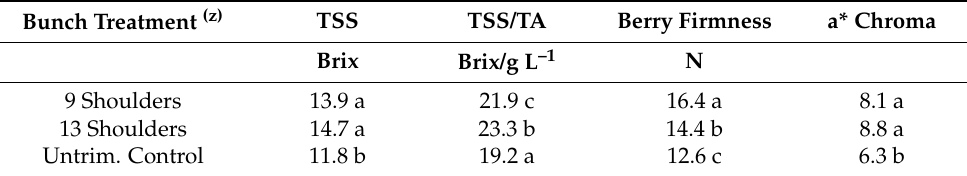
Table 7. Effect of bunch trimming on berry ripening, and physical and chromatic properties of ‘Red Globe’ table-grape vines at a theoretical plant density of 15,600 plants ha − 1 under soil-less cultivation z